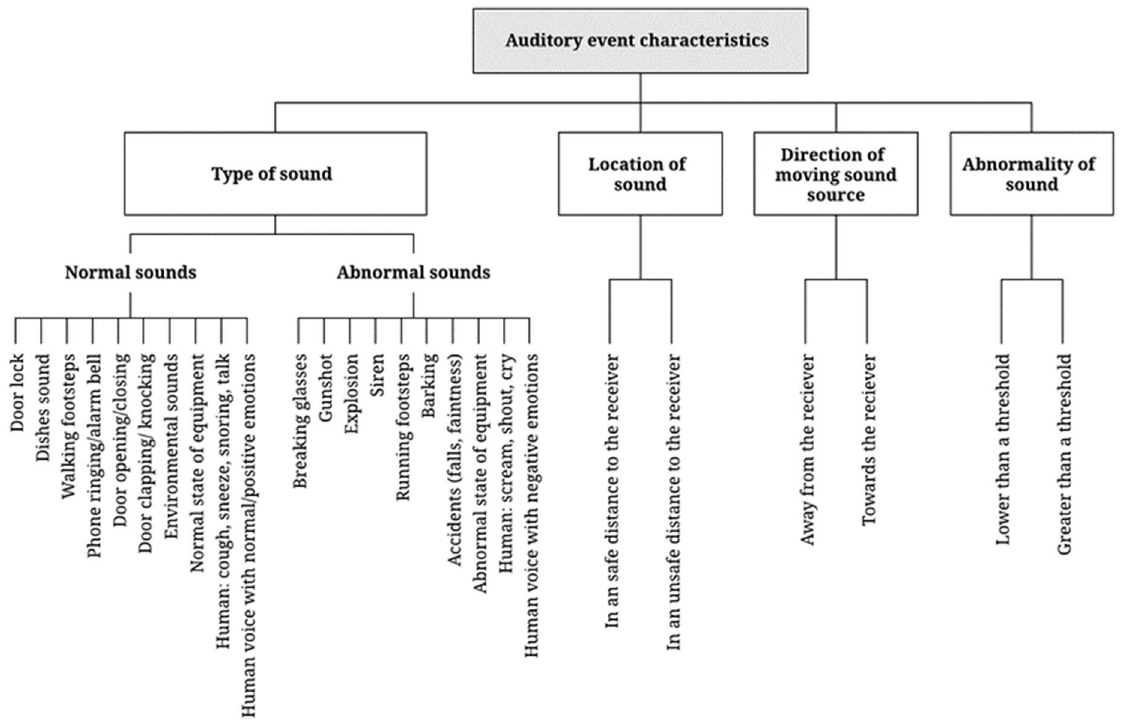
Figure 7. Indicators of hazardous events.